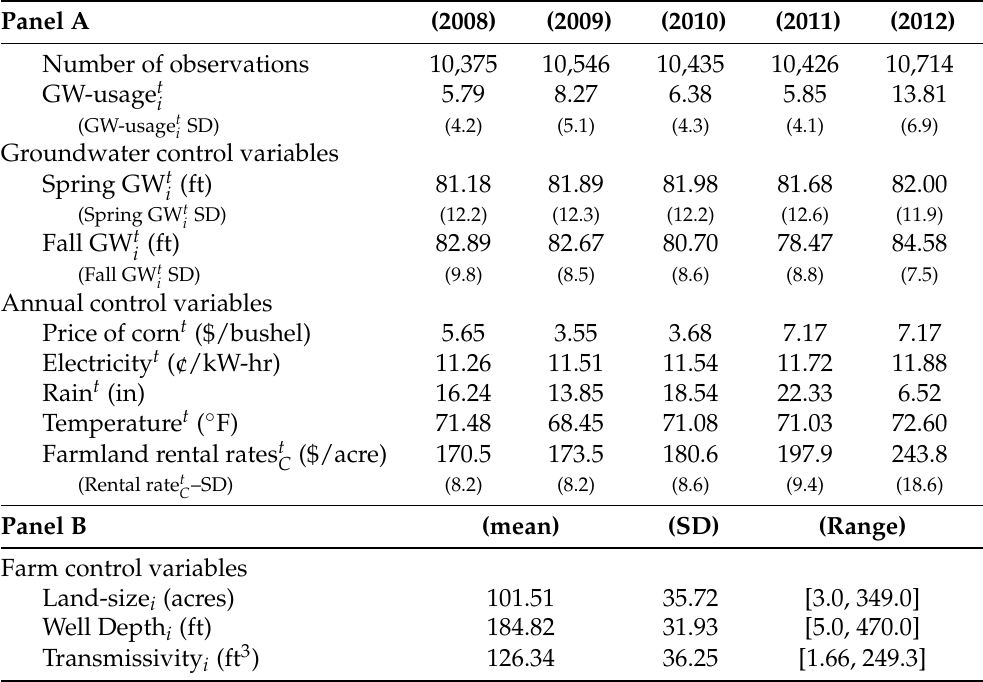
Table 1. Descriptive statistics of groundwater (GW) usage and other variables in the Upper Big Blue District,